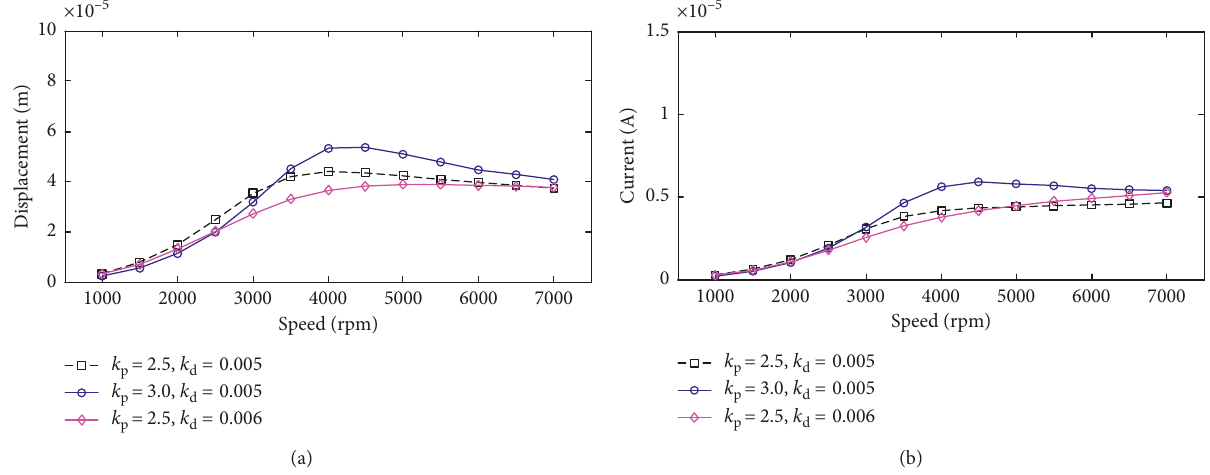
Figure 4: Vibration response under different PID parameters: (a) vibration displacement and (b) control